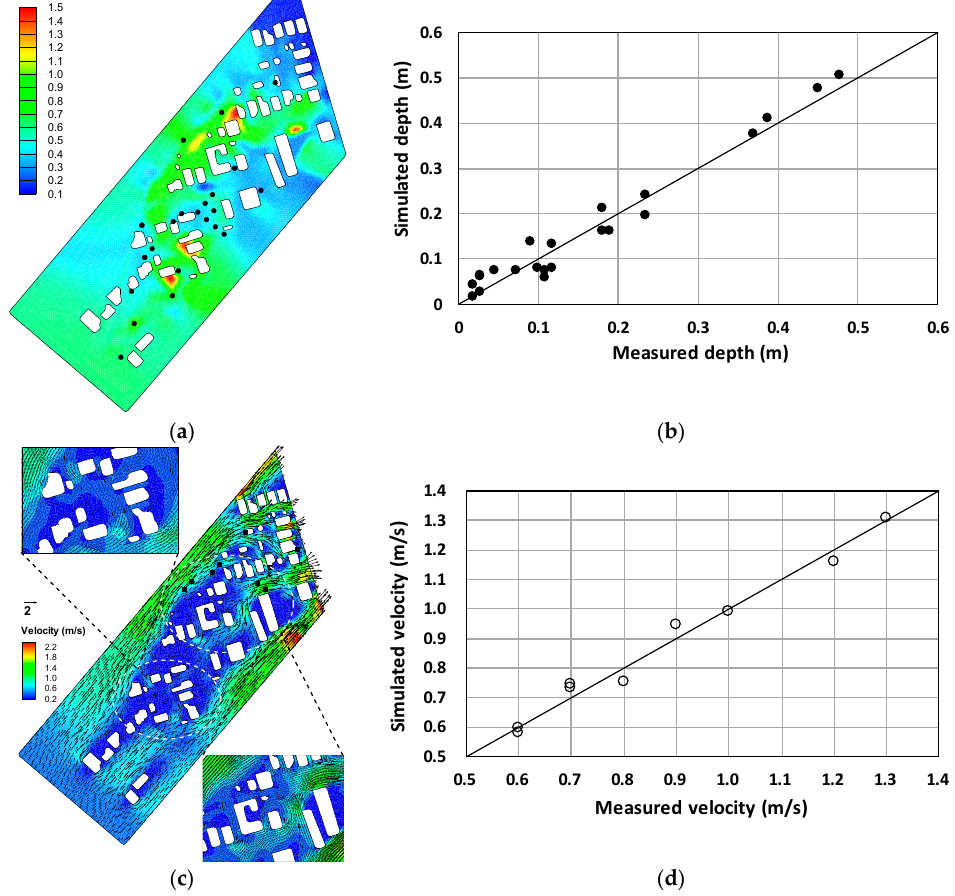
Figure 4. Comparison of inundation characteristics: ( a ) depth and comparison points; ( b ) scatter plot for depth comparison; ( c ) velocity vector; ( d ) scatter plot for velocity comparison.